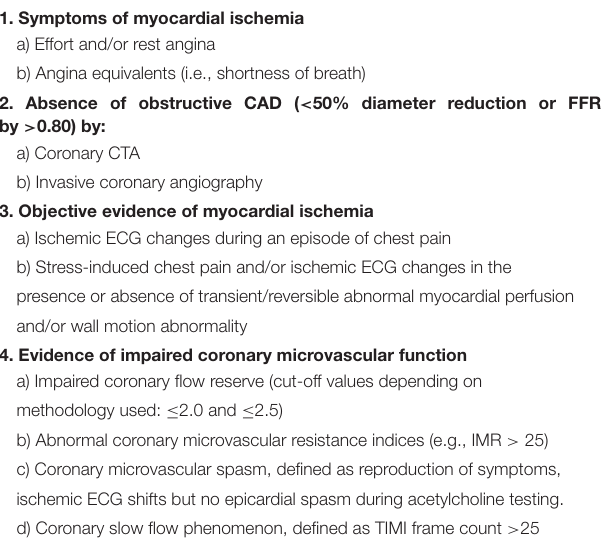
TABLE 3 | Diagnostic criteria for coronary microvascular dysfunction